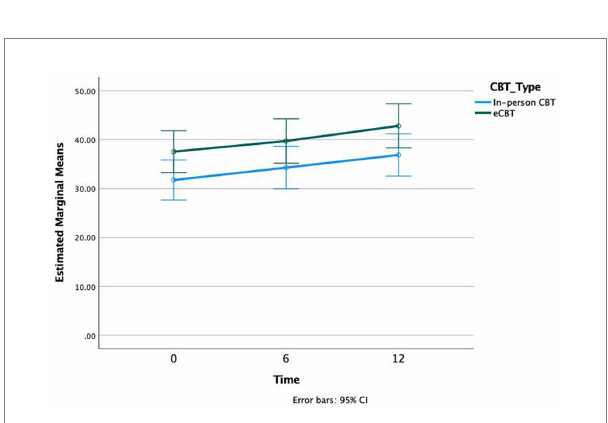
FIGURE 4 Quality of Life Enjoyment and Satisfaction (Q-LES-Q) scores at three time intervals of treatment, Weeks 0, 6, and 12, in both in-person and e-CBT treatment conditions.